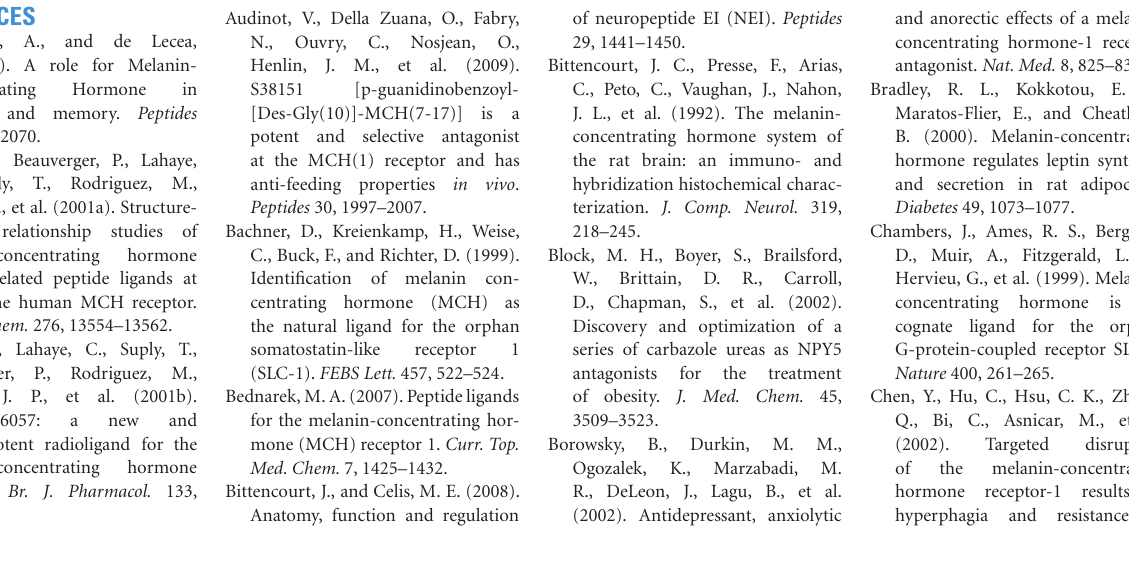
Bednarek (2007), peptide ligands at MCH 1 were used in vivo